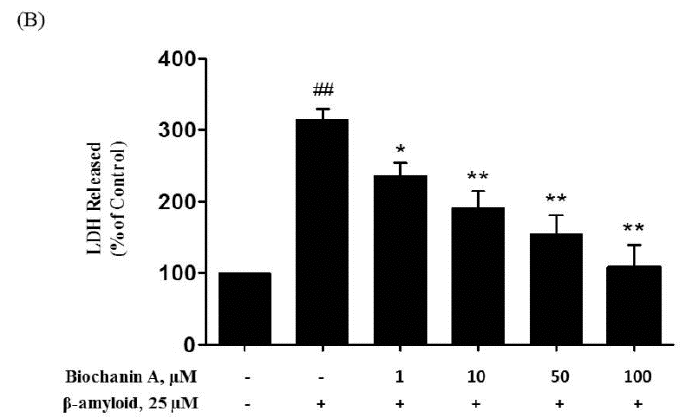
Figure 1. Effect of biochanin A on A β 25–35 -induced cytotoxicity and LDH leakage. ( A ) Cell viability as